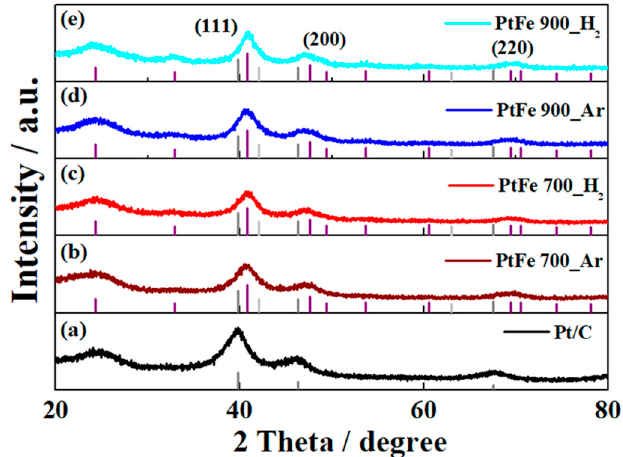
Figure 2. X-ray diffractometer (XRD)patterns of ( a ) Pt/C, ( b ) PtFe 700_Ar, ( c ) PtFe 700_H 2 , ( d ) PtFe 900_Ar, and ( e ) PtFe 900_H 2 . In the figures, the standard XRD peak patterns of fcc Pt (JCPDS# 87-0646, dark grey), ordered tetragonal PtFe (JCPDS# 65-1051, Ivory), and bcc Fe (JCPDS# 89-4186, light grey) are indicated.